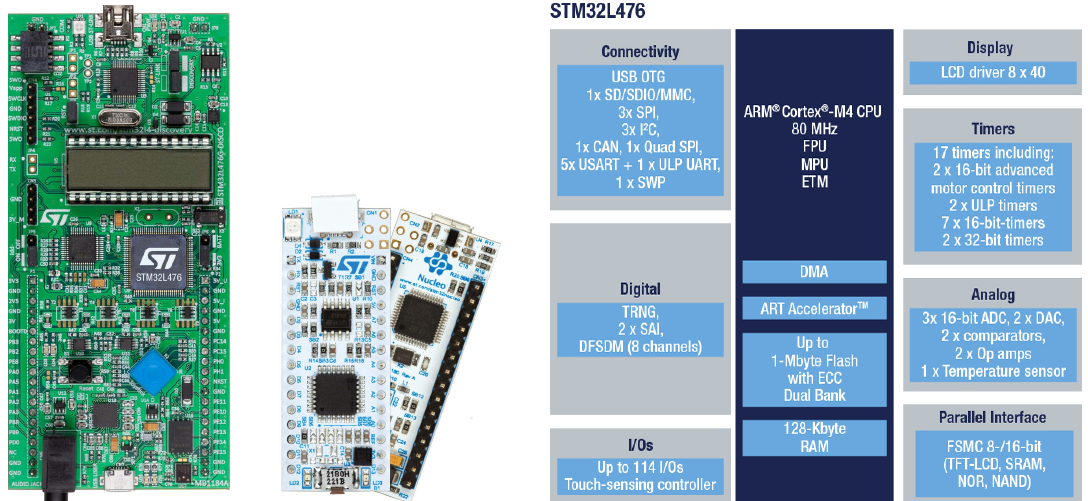
Figure 2. Development kits L476Discovery ( left ), L432Nucleo ( middle ), and a summary of resources in STM32 SoC included ( right